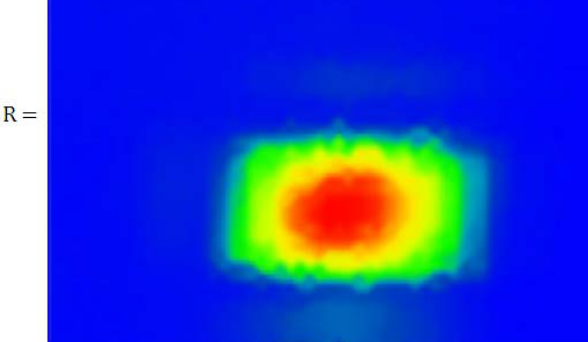
Figure 8. Temperature affected area for calculation The pattern of the temperature distribution and its classification with respect to the interval of alarm- temperature levels is shown in Fig. 9 below: